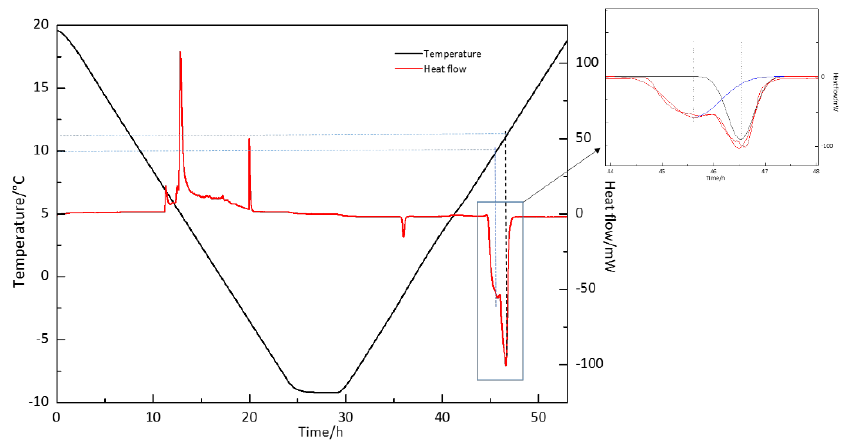
Figure 11. Heat flow and temperature curve at 20.0~ −8.8 °C and 6.0 MPa.